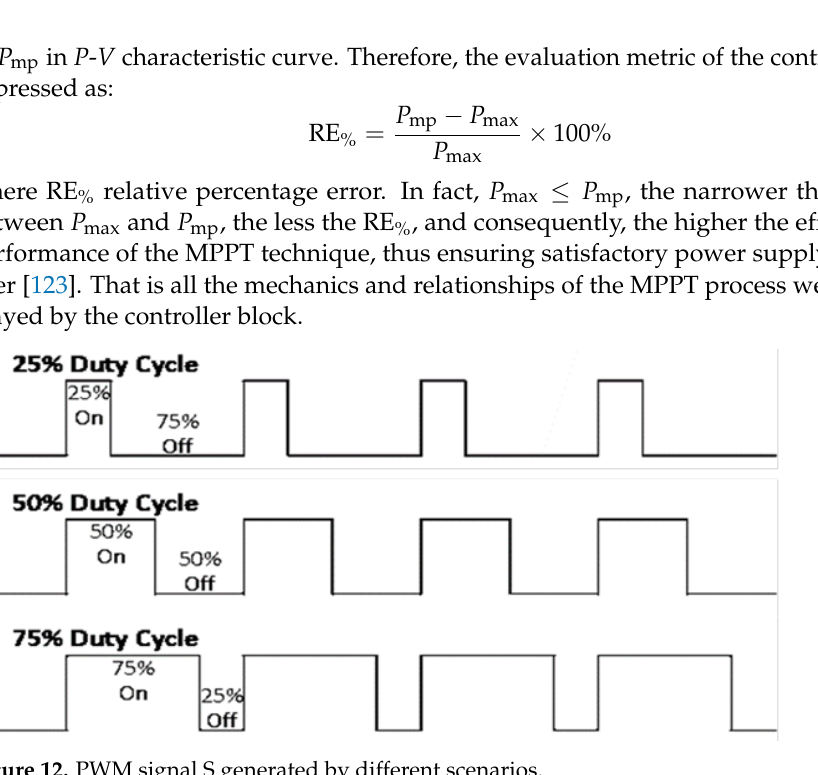
Figure 12. PWM signal S generated by different scenarios.